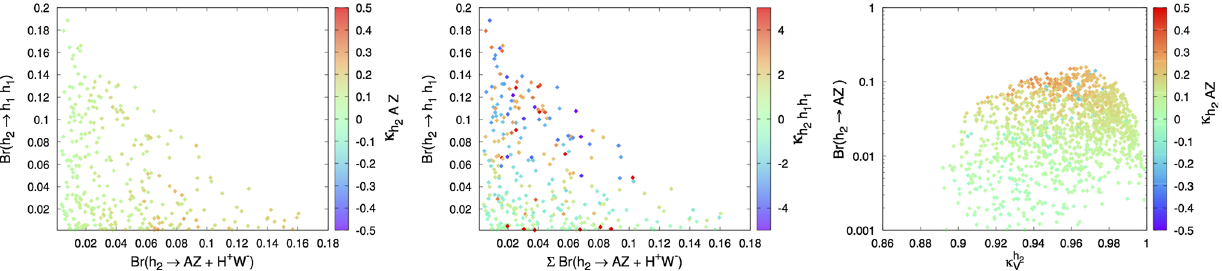
Fig. 6 Correlations: between κ h 2 gg and κ h 2 γγ versus R 2 95% C . L